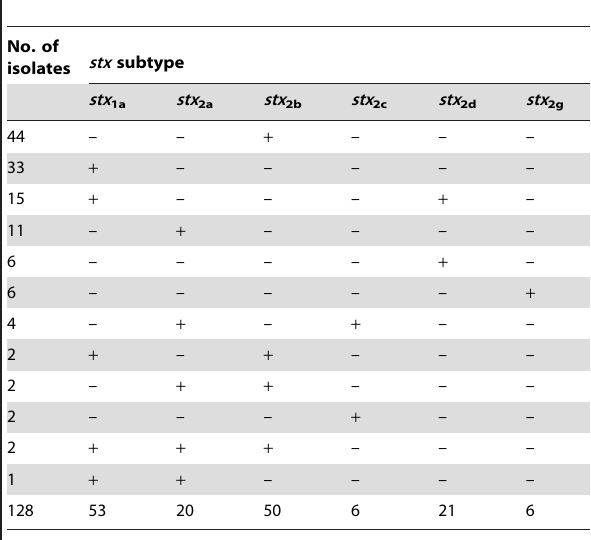
Table 4. Summary of stx subtyping in 128 STEC